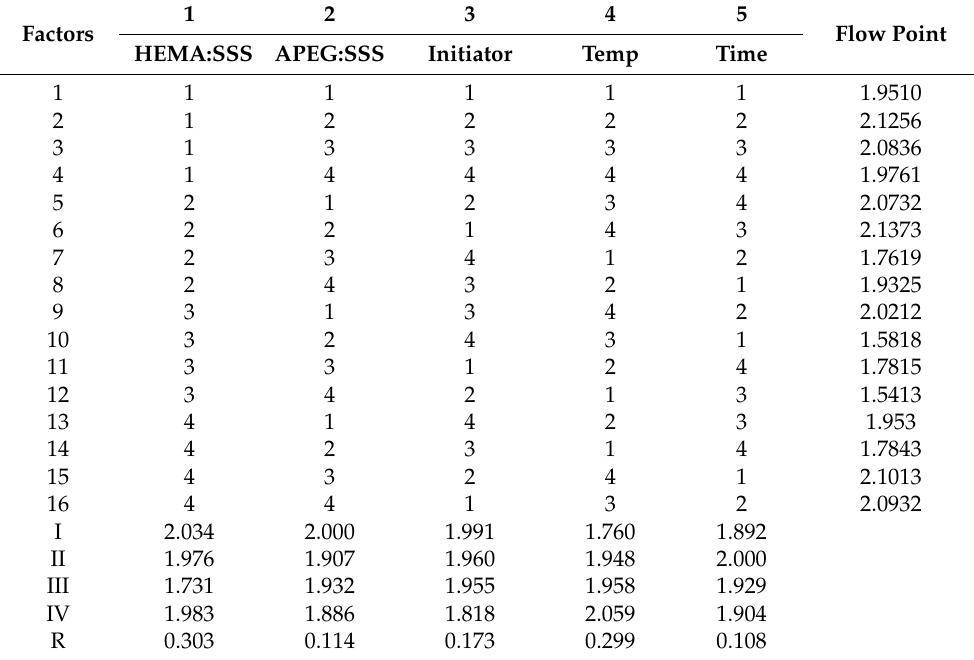
Table 2. The results of L 16 (4 5 ) orthogonal